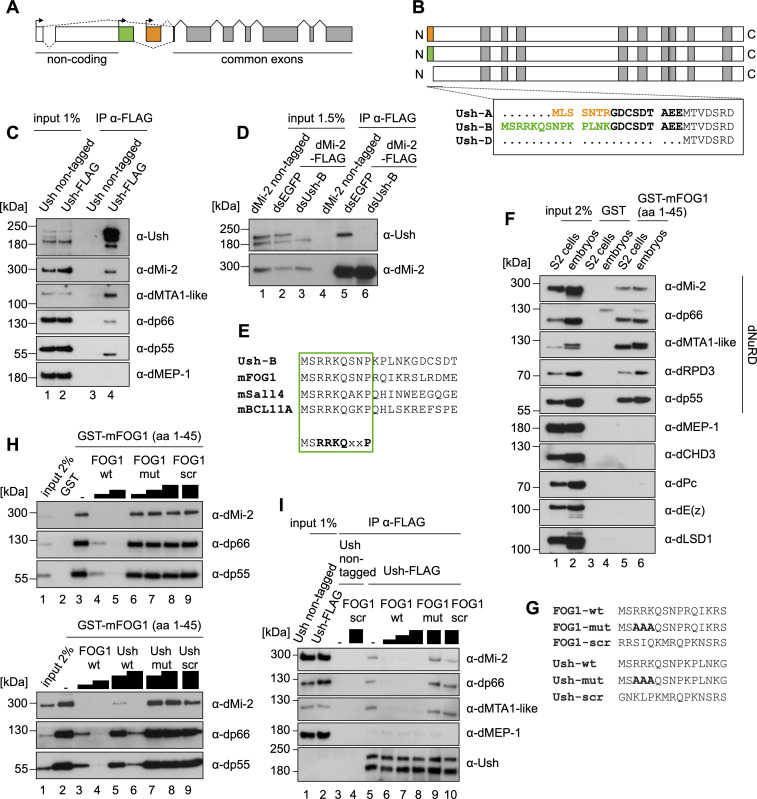
The Ush isoform Ush-B interacts with NuRD via a conserved N-terminal motif.A Schematic structure of the Ush gene locus. Boxes represent exons and the connecting lines indicate splicing events (dashed lines: alternative splicing). Exons marked in grey are common to all Ush isoforms. (Sections of) exons marked in white are untranslated. Possible transcriptional start sites are indicated by arrows. B Scheme of polypeptides generated from the Ush gene. Zinc finger domains are marked in grey. Sequences in the box indicate the N-termini of Ush proteins emanating from five possible Ush mRNAs. Isoform specific N-termini are marked in orange and green. C Anti-FLAG immunoprecipitation of nuclear extract from control and Ush-FLAG expressing cells. Antibodies used for examination of co-precipitation by Western blot are indicated on the right. D Anti-FLAG immunoprecipitation of nuclear extract from control and dMi-2-FLAG expressing cells following Ush-B depletion (dsUsh-B) or cells transfected with control dsRNA (dsEGFP). Co-precipitation of Ush was determined by Western blot. E Sequence alignment of the Ush-B N-terminus with N-terminal sequences from murine proteins containing the FOG repression motif (in bolt letters below). F GST pulldown from nuclear extracts of S2 cells or Drosophila embryos using the first 45 amino acids of murine FOG1 fused to GST (GST-mFOG1 (aa 1-45)) or control bait (GST). Interacting proteins were analysed by Western blot against NuRD complex components (specified on the right) and additional chromatin-regulating proteins. Antibodies used for immuno-detection are indicated on the right. G Sequences of peptides derived from FOG1 and Ush-B N-termini that were used in competition experiments. H GST pulldown assays from S2 cell nuclear extracts using the GST-mFOG1(1-45) fusion protein. Pulldown reactions were performed in presence of different concentrations of the indicated peptides (FOG1 derived peptides: top panel; Ush-B derived peptides: bottom panel). Interaction of NuRD with the GST-fusion was detected by Western blot using antibodies indicated on the right. I Anti-FLAG immunoprecipitation of nuclear extract from control and Ush-FLAG expressing cells in presence of FOG1 derived peptides. The identity of peptides and the amount used is indicated above. Antibodies used for examination of co-precipitation by Western blot are indicated on the right.